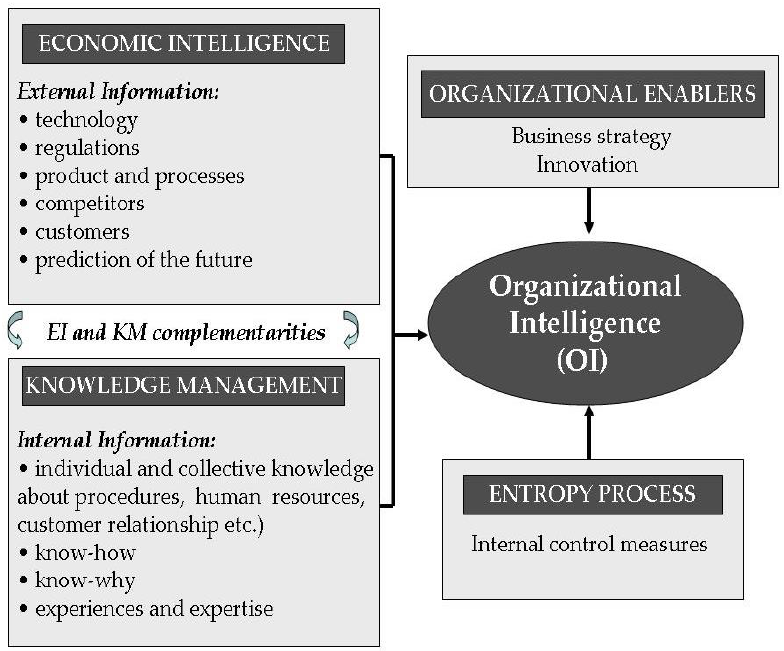
Figure 1. Theoretical framework of OI.